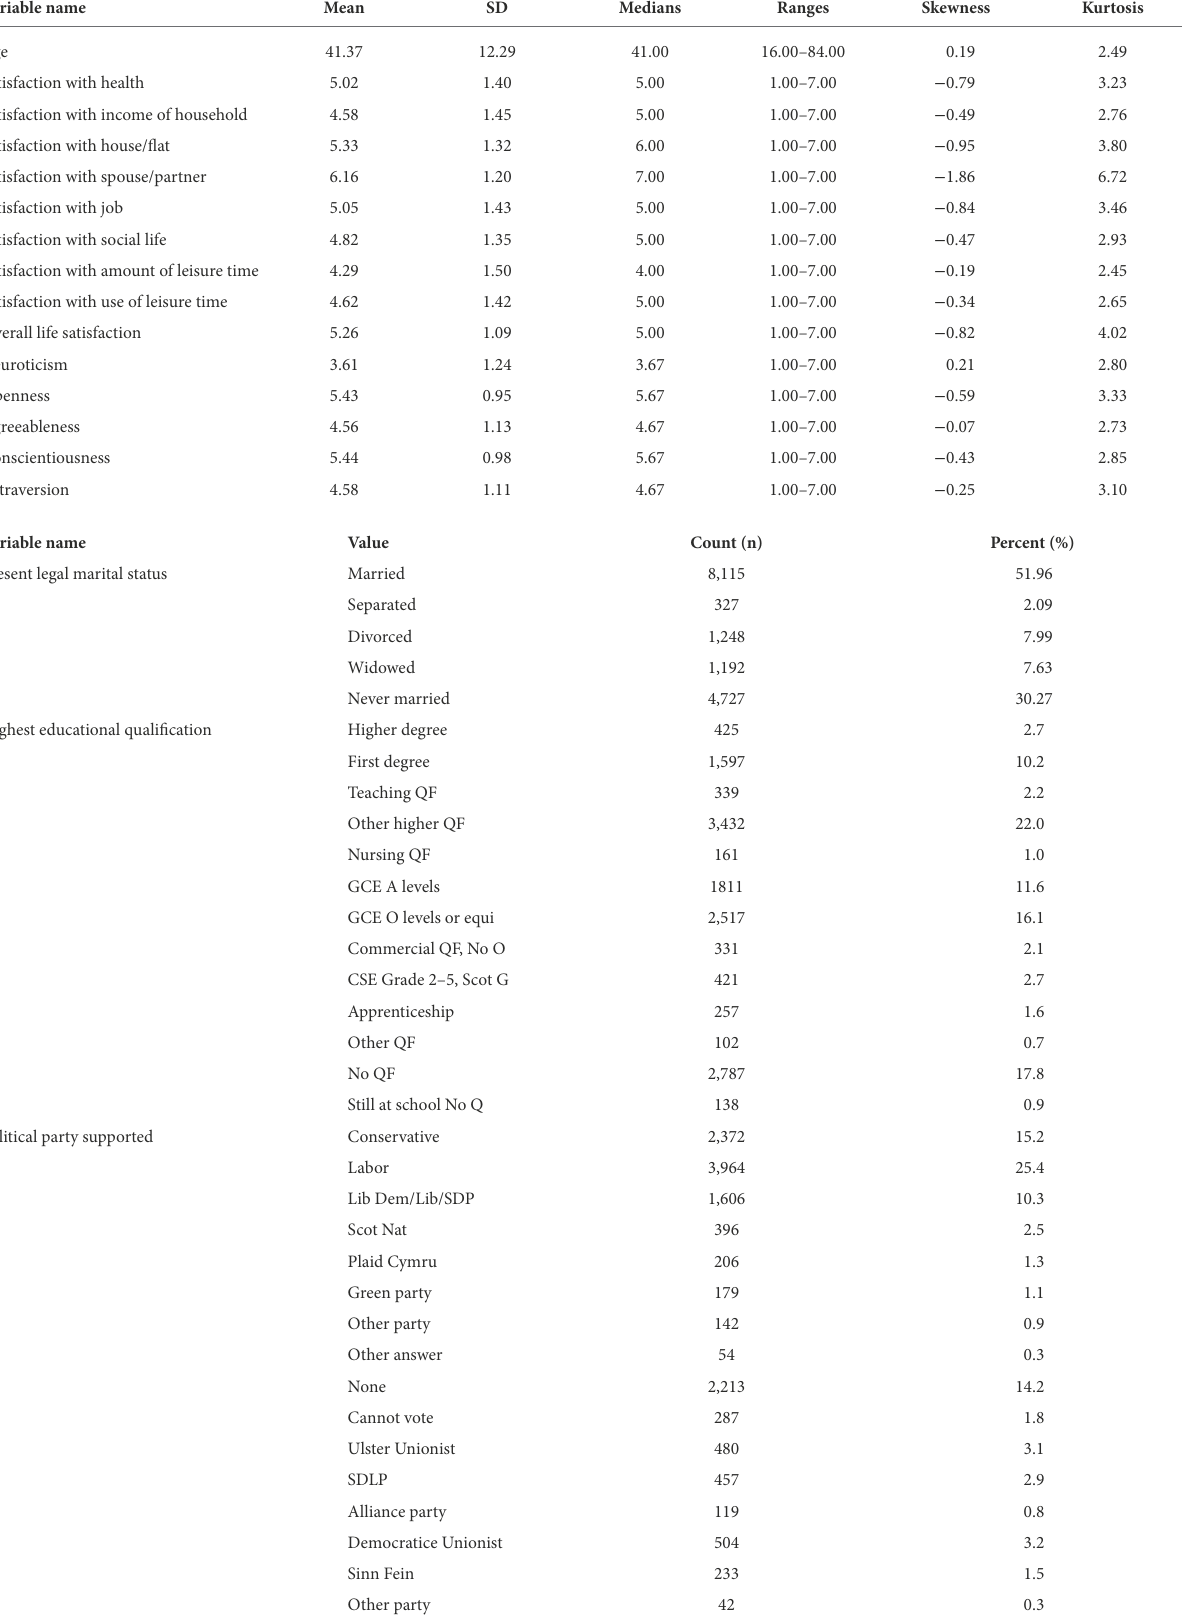
TABLE 1 Descriptive statistics for continuous and categorical